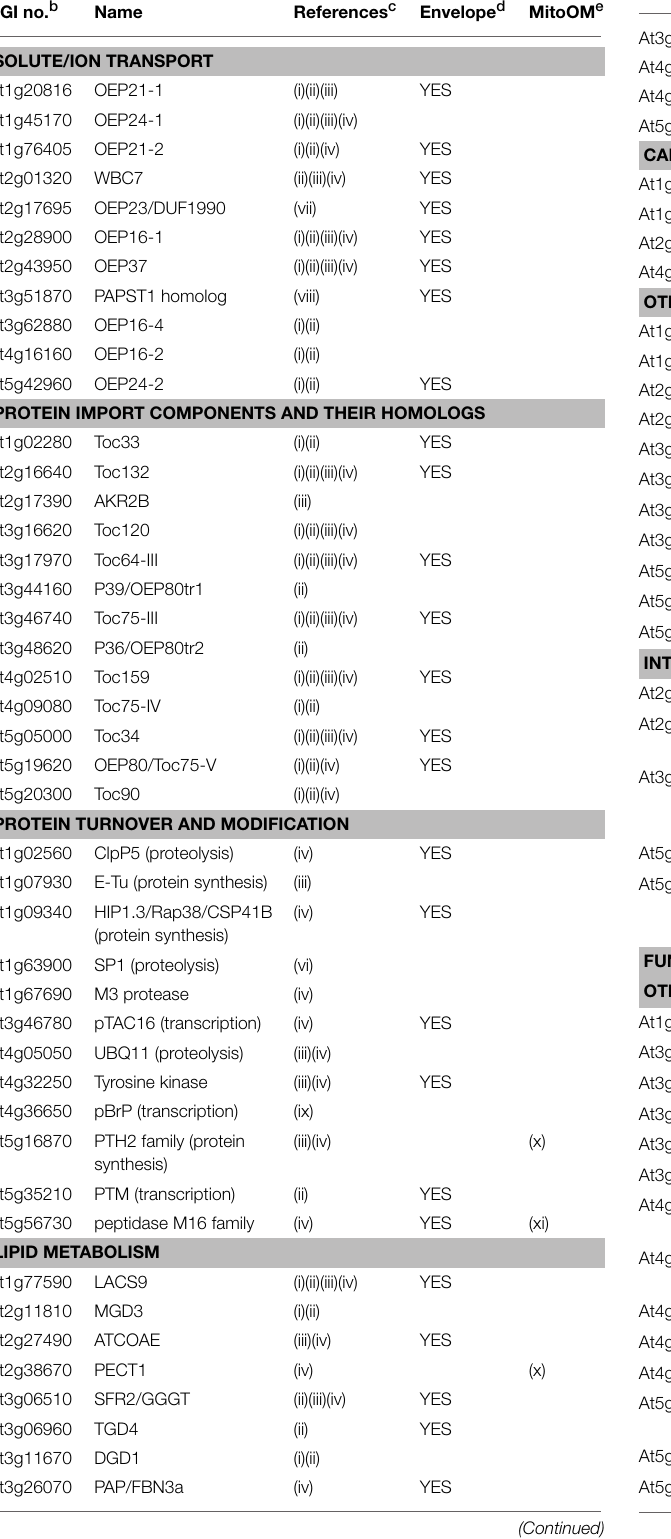
TABLE 1 | One hundred and seventeen proteins identified or predicted to be in the outer membrane of the Arabidopsis chloroplast envelope. a AGI no.